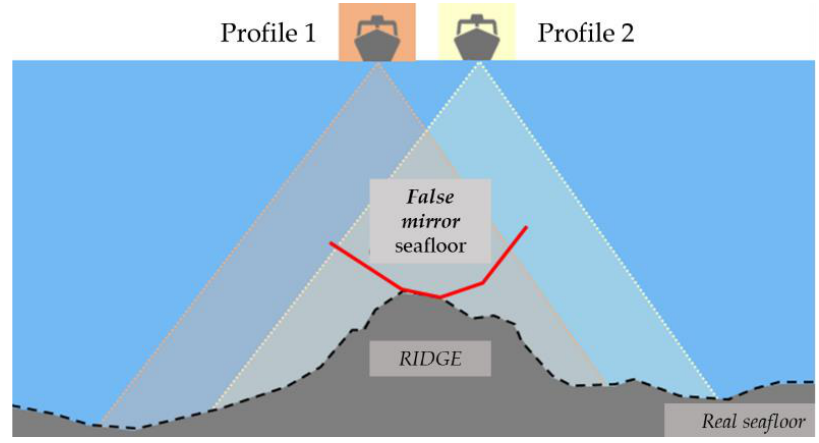
Figure 11. An example of the false mirror bottom artifact formation.